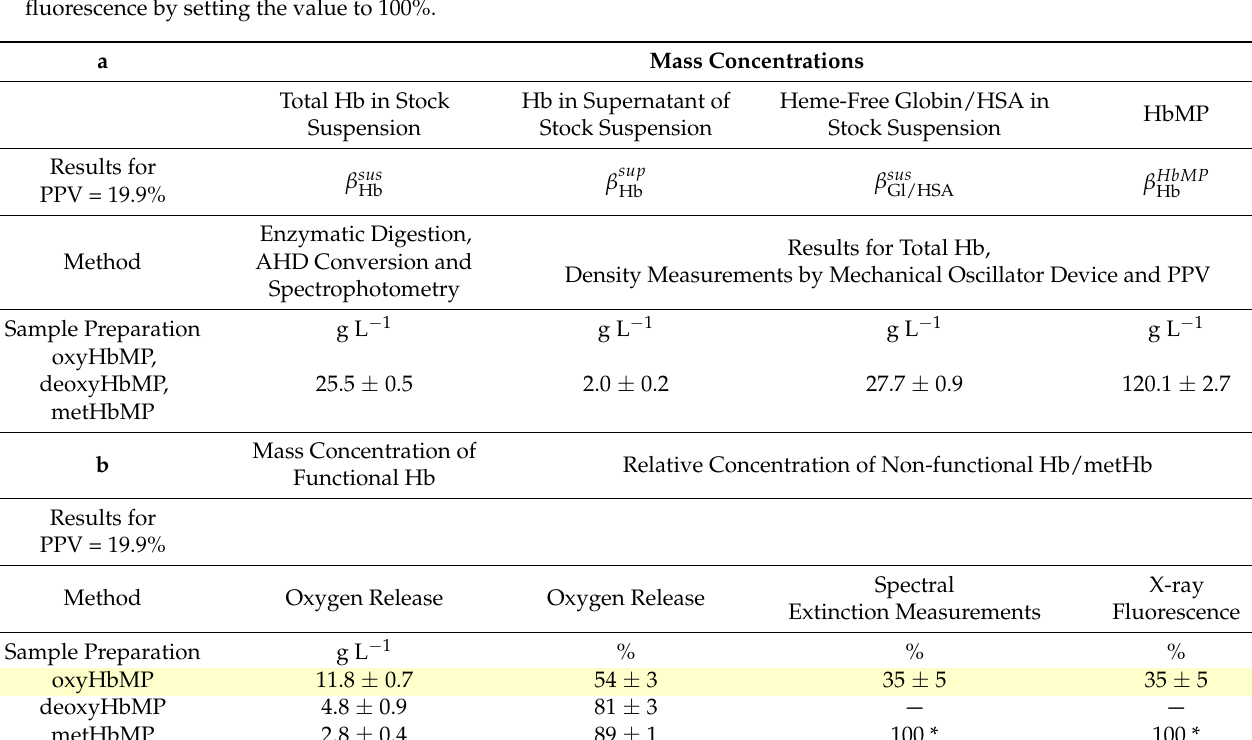
Table 2. ( a ) Total hemoglobin concentrations in the various components of the HbMP suspension and total concentration of heme-free globin/HSA. ( b ) Concentrations of functional Hb and relative concentrations of metHb. * The HbMP suspension with all Hb variants converted to metHb was used for validation of the spectral extinction measurements and the X-ray fluorescence by setting the value to